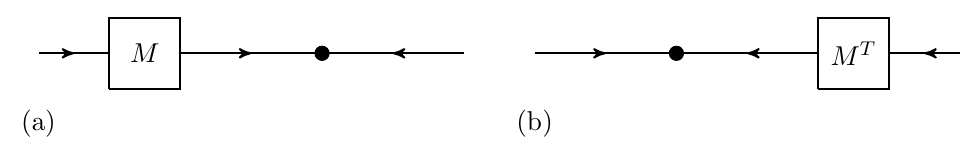
Figure 3. (a) An operator M ⊗ I applied to a quantum state. (b) In the case where the vertex represents a maximally entangled state, the operator M can be moved to the other subspace by taking the transpose.